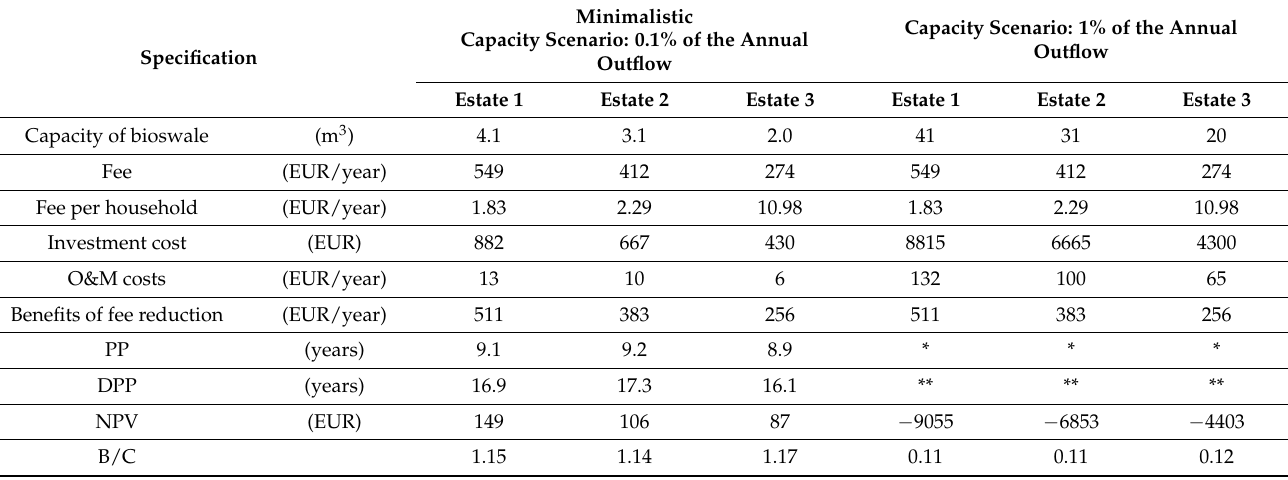
Table 10. Cost-effectiveness of rainwater management using retention through bioswales with capacities of 0.1% and 1% of the annual